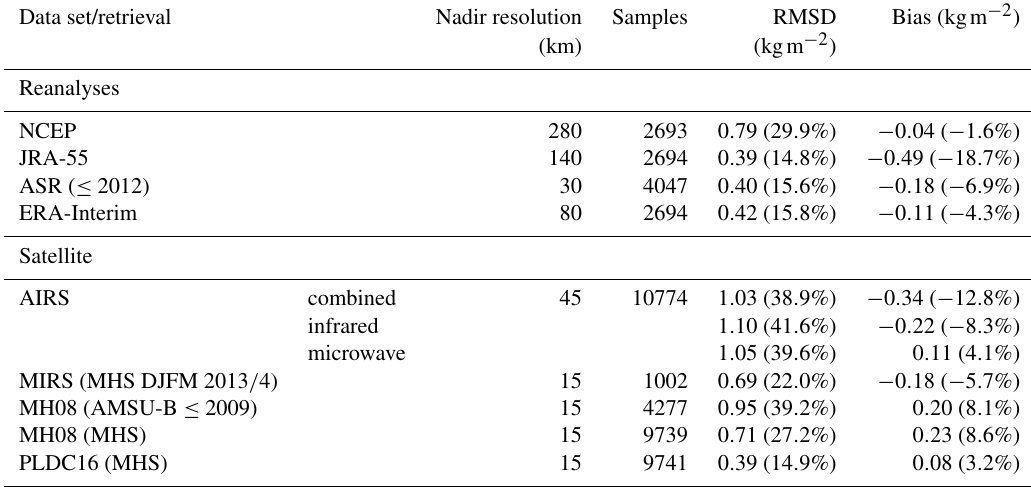
Table 5. Water vapour column root mean square deviations (RMSDs) for various data sets against GVR measurements for columns less than 6kgm − 2 . Values in brackets give the deviations and biases as a fraction of the mean column amount. Data